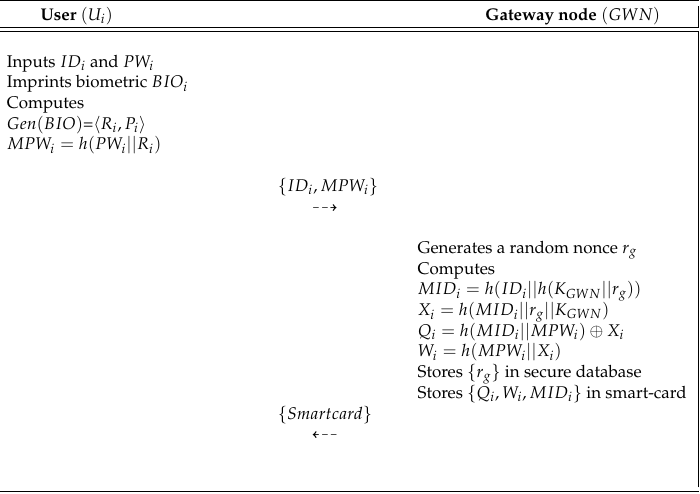
Figure 5. User registration process of our